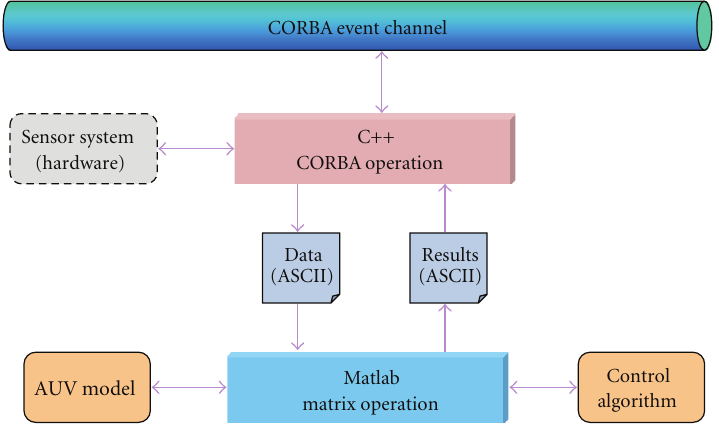
Figure 2: Matlab and C++ interfaces.